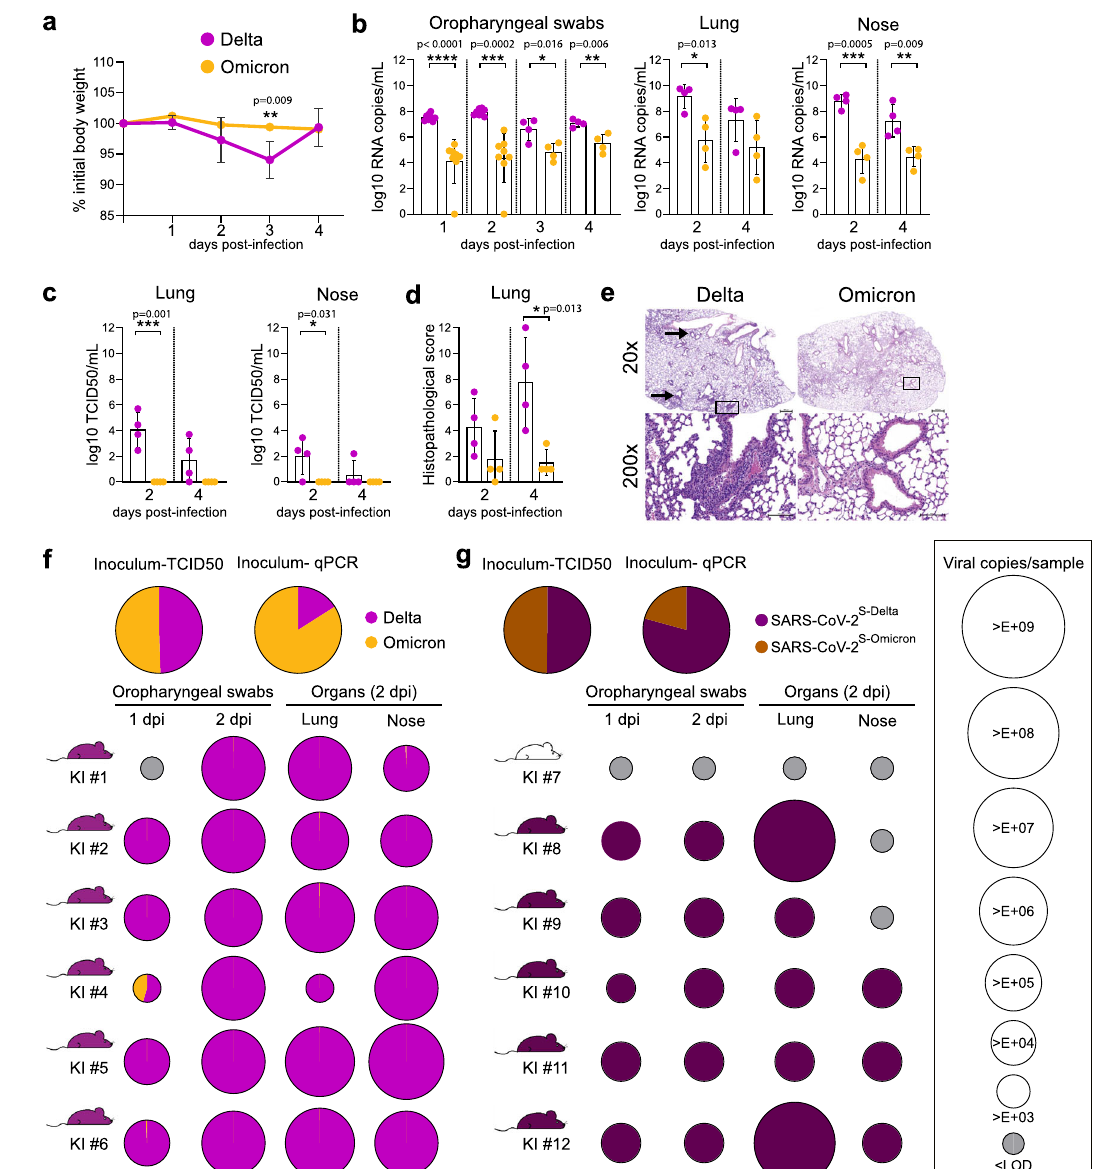
Fig. 3 | Delta spike mutations drive enhanced fi tness in hACE2-knock-in mice. a – e hACE2-KI mice (7 – 16week-old male, n =8 mice/virus) were intranasally inoculated with 10 4.3 TCID 50 of Delta or Omicron. a Average relative weight loss after infection (Relative weight loss data from each animal is given in Supplemen- tary Fig. 9). b Viral copies per mL of oropharyngeal swabs or per lung and nose sample ( n =16 mice) quanti fi ed using E-gene probe-speci fi c RT – qPCR. c Infectious virus titers from the lung and nose samples ( n =16 mice) determined using TCID 50 assaysinVeroE6/TMPRSS2cells. d , e Histopathologicalscoreand hematoxylinand eosinstainingfromDelta-andOmicron-infectedlungsections( n =16mice)at2and 4dpi. Perivascular and peribronchiolar lymphohistiocytic in fl ammation are high- lighted with anarrow, and the highermagni fi cation represented inthe lowerpanel correspondstotheareashighlightedbyasquareintheupperpanel.Scalebars,500 (upper panel) and 100 µ m (lower panel). Data are mean±s.d. from the indicated number of biological replicates from a single experiment. The color key in a also appliestob,candd.Statisticalsigni fi cancewasdeterminedusinganunpairedtwo-